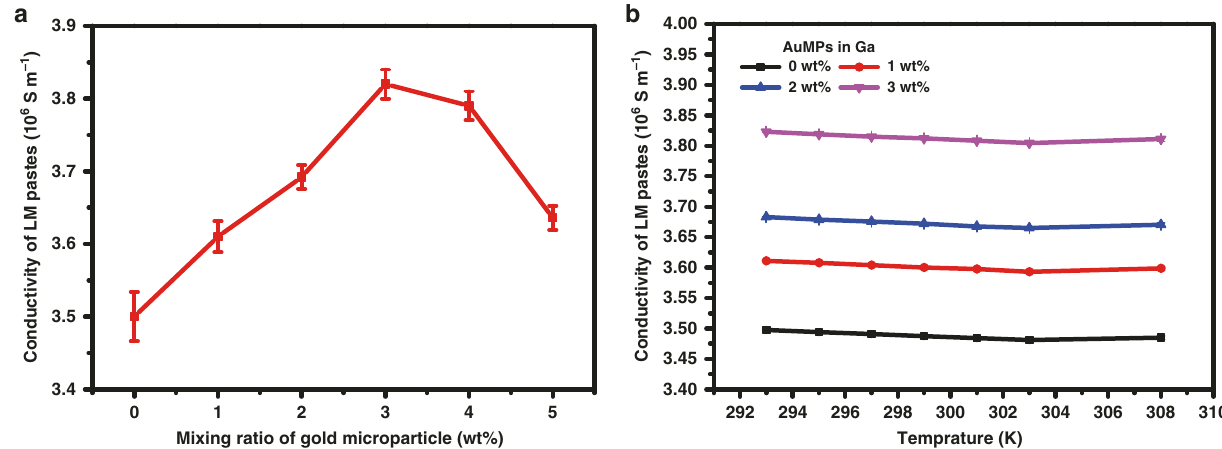
Fig. 2 Multi-proportion electrical performance and temperature-dependence characteristic measurement of LM pastes. a Conductivity of LM pastes consisting of gold microparticles (AuMPs) and gallium with different mixing ratios. b Temperature dependence of the conductivity of gold microparticles in gallium with different mixing ratios. Data represent means ± s.d. from fi ve ( a ) and three ( b ) independent replicates. Source data are provided as a Source Data fi pastes 20 , we chose gallium (Ga) and its alloys (e.g. EGaIn) as